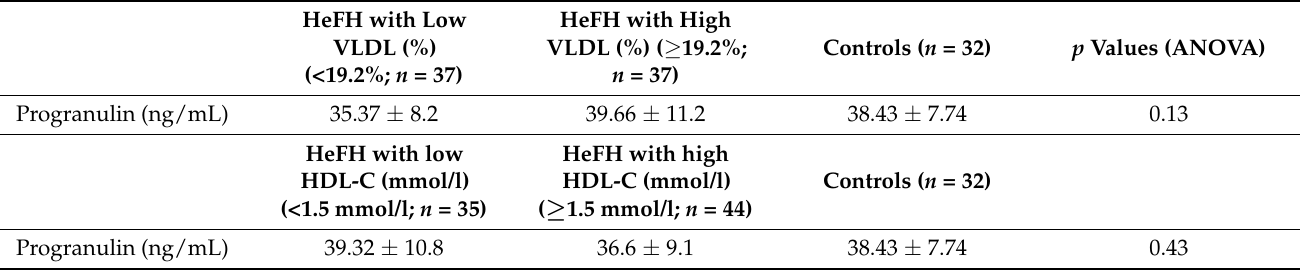
Table 3. The mean values of progranulin in FH patients with a low and high median of VLDL subfraction (%) and in FH patients with a low and high median of HDL-C compared to the controls. The values are presented as mean ± standard